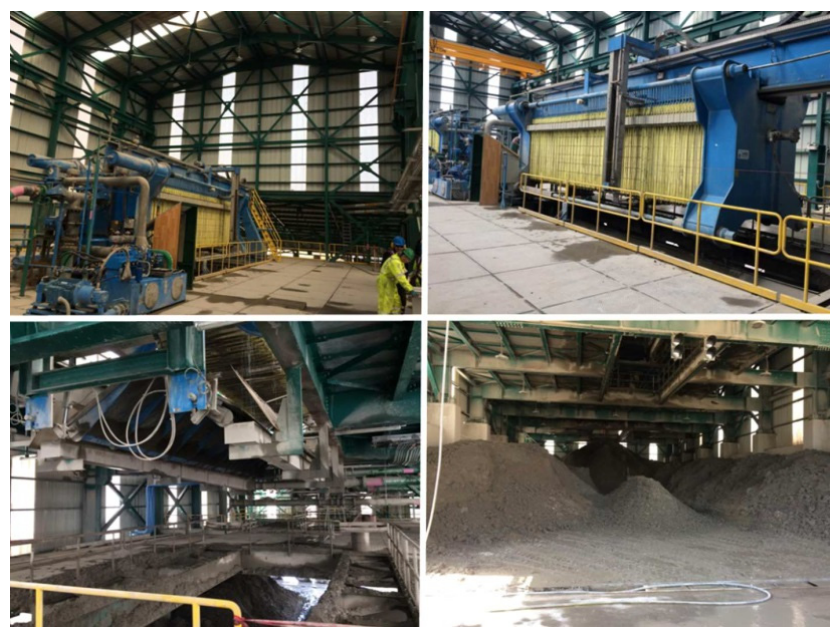
Figure 72. Tambomayo Tailings Filtering Plant [42,43].